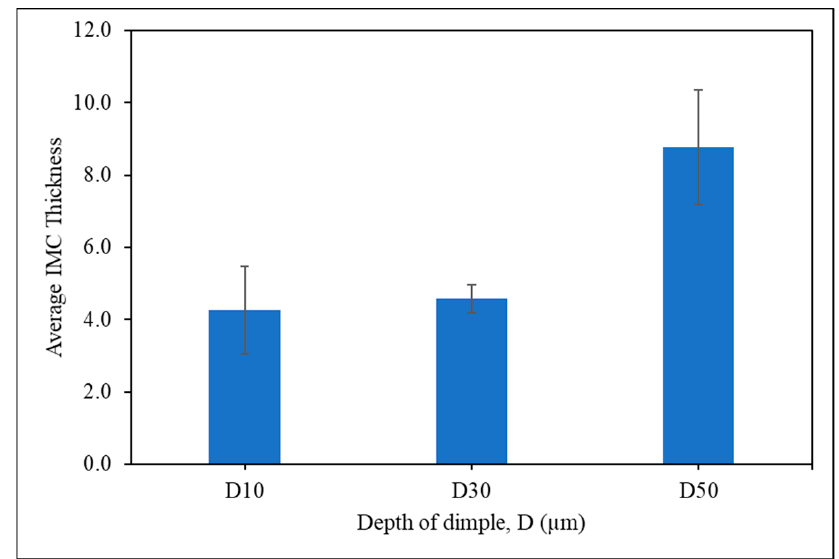
Figure 9. Average IMC thickness of solder joint.